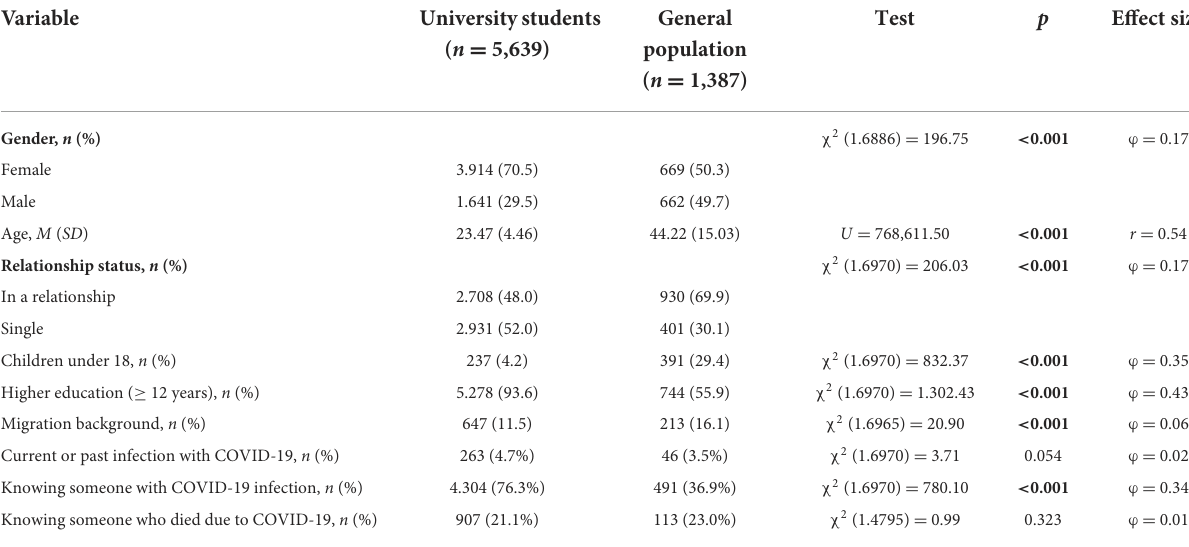
TABLE 1 Sociodemographic characteristics and group differences between university students and the general population.